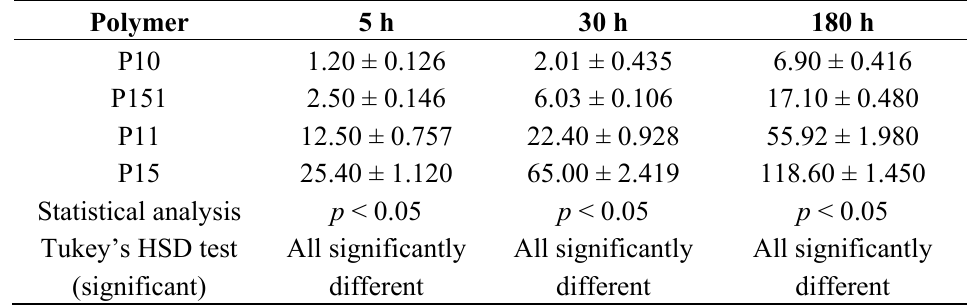
Table 3. Results of statistical comparisons of thiol concentration (×10 − 6 mol L − 1 ) of various molar combinations of polymers at incubation times of 5, 30, and 180 h in phosphate buffer medium containing B. fragilis . Mean ± SD, n =